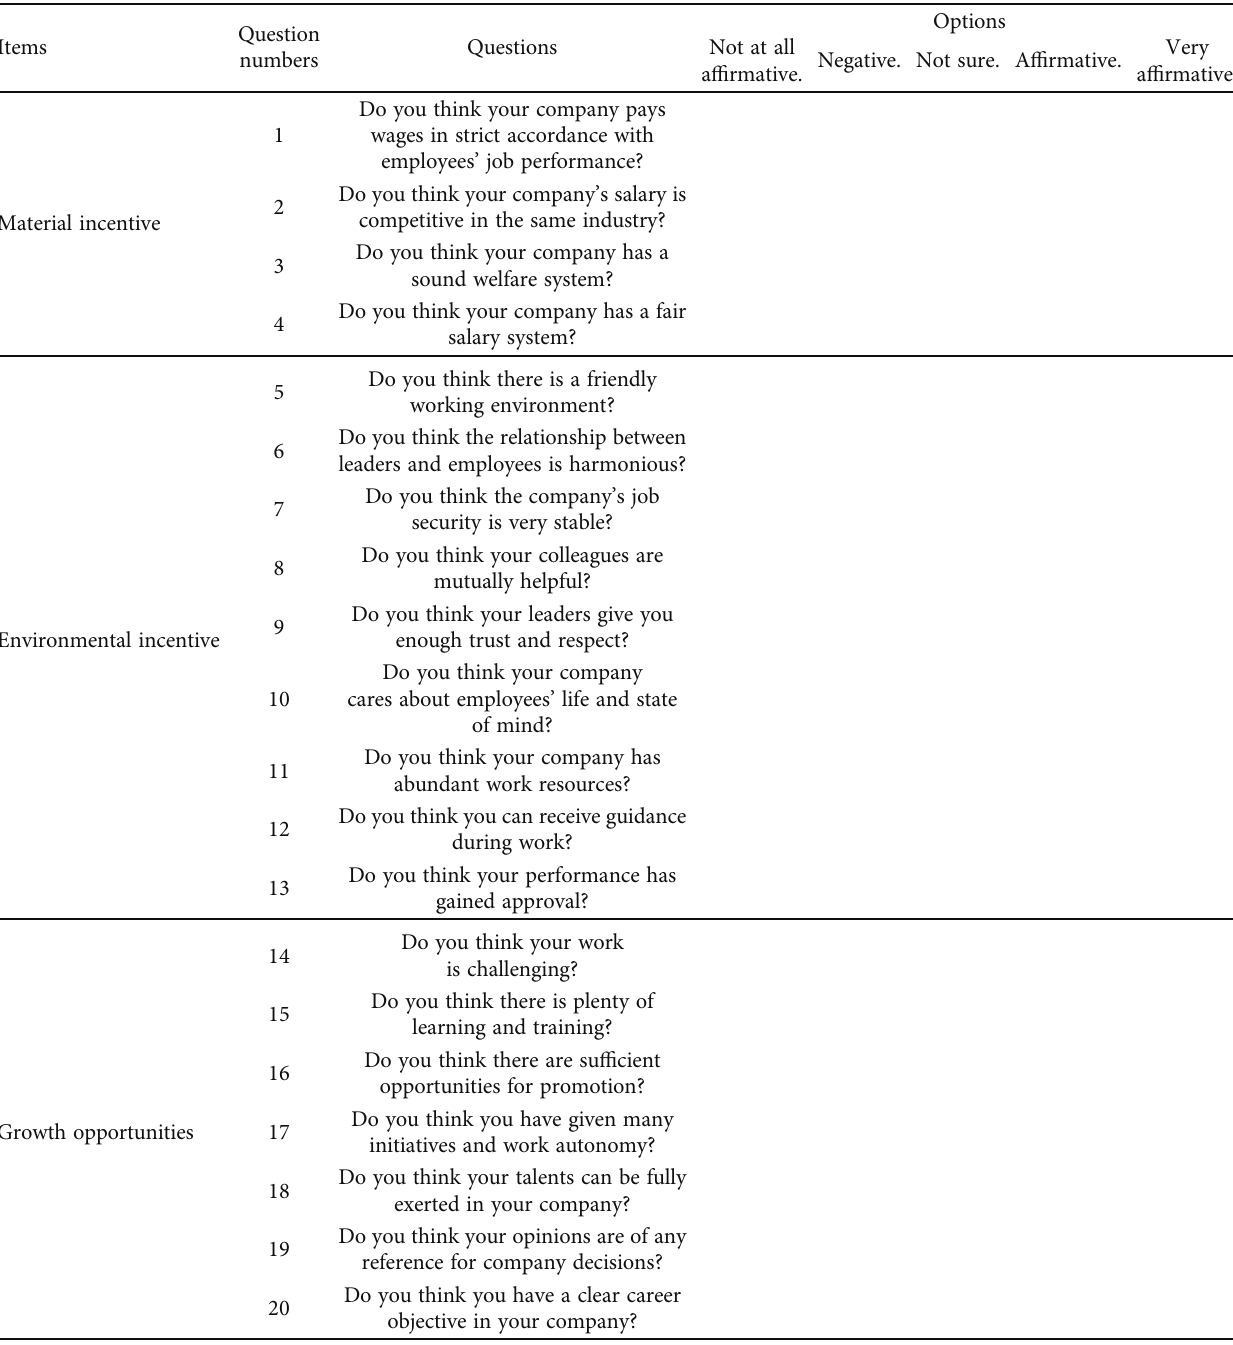
Table 1: Psychological contract